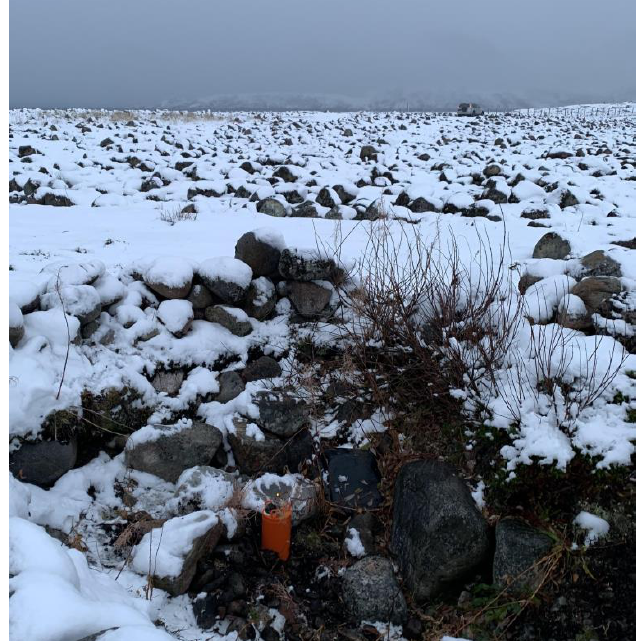
Figure 10. Installation of a geohydroacoustic buoy near the Teriberka village (Murmansk region, Russia) in frames of the Arctic expedition organized by the Russian Geographical Society in 2020.